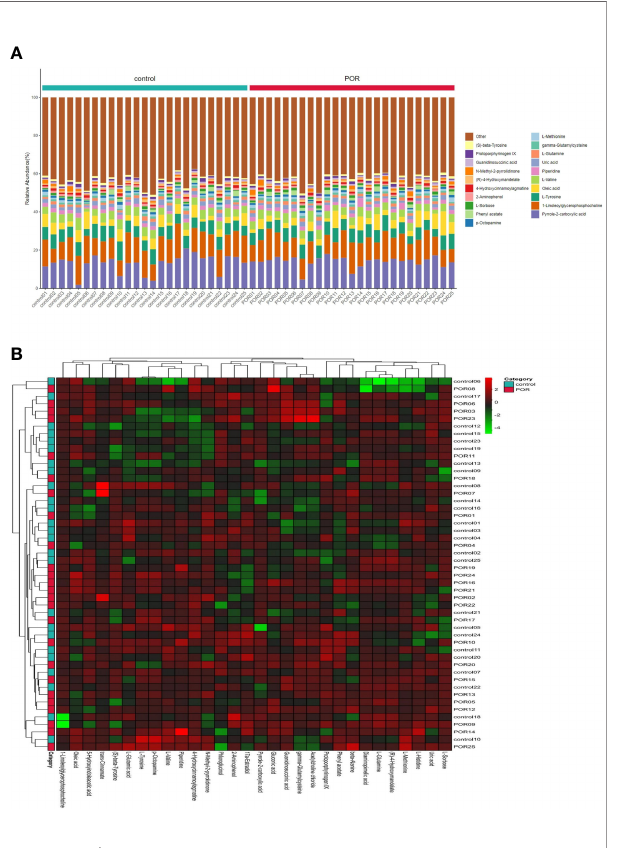
FIGURE 3 | Accumulation histogram (A) and heat-map (B) of differential metabolites visualized the variations of metabolite pro fi les of POR and controls. (A) The abscissa is the sample name, which is sorted according to the grouping order, and different grouping samples are marked with different colors. The ordinate represents the percentage content of each metabolite, and the column order of corresponding metabolites from top to bottom is consistent with the legend. (B) The vertical axis is the sample name information, and also includes the grouping information. The horizontal axis is the metabolite. The cluster tree at the top of the fi gure is the similarity cluster of the distribution of metabolites in each sample, and the cluster tree at the left is the sample cluster tree, and the heat map in the middle is the heat map of metabolite content. The relationship between color and Z-score is shown in the scale at the top